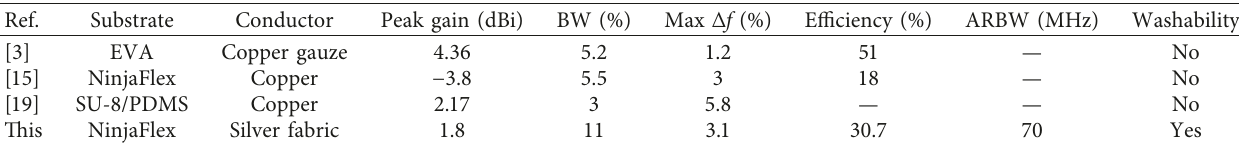
Figure 12: Washing test. (a) Antenna in the washing machine. (b) Measured S 11 before (solid curves) and after (dashed curves) washing. Table 2: Comparison of flexible antennas reported in the literature.